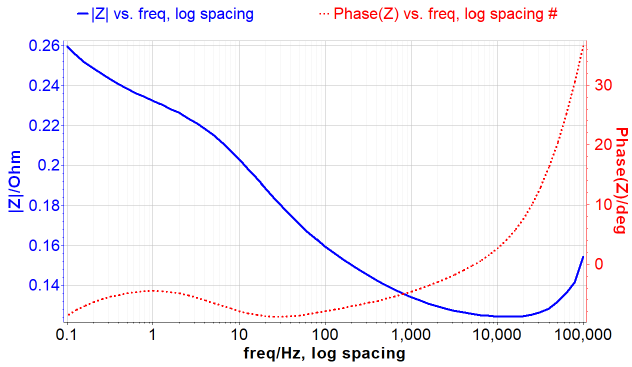
Figure 7. Bode magnitude and phase plot for equivalent battery circuit model. Table 2. Control factors for Taguchi OA design.